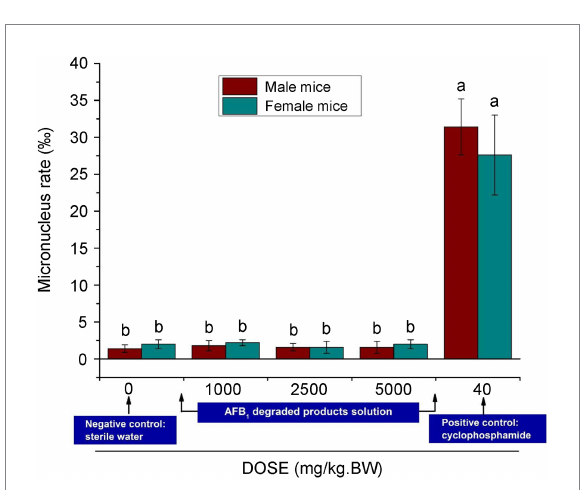
FIGURE 6 Effects of heat, protease K, protease K plus sodium dodecyl sulfonate (SDS), and Ethylene diamine tetraacetic acid (EDTA) on the aflatoxin B 1 (AFB 1 ) degradation activity of the culture supernatant of T. reesei CGMCC3.5218. Bars with different letters are significantly different for p < 0.001 (Tukey–Kramer multiple comparison test). The values are the means of three replicates and their standard errors.